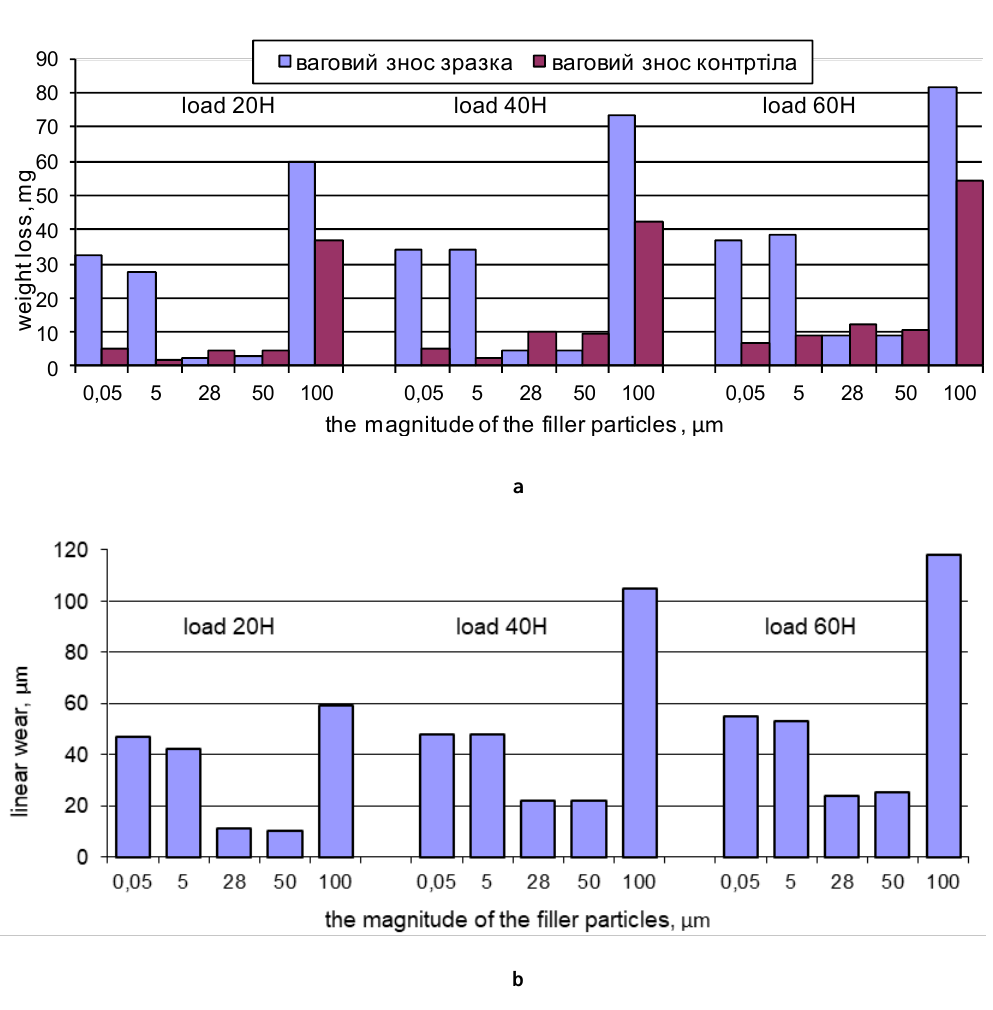
Fig. 5. Wearing resistance of Ni-SiC СEС, depending on the size of the filler: a – weight wear of the sample and countertick, mg / km; b – linear friction pair of friction, μm /